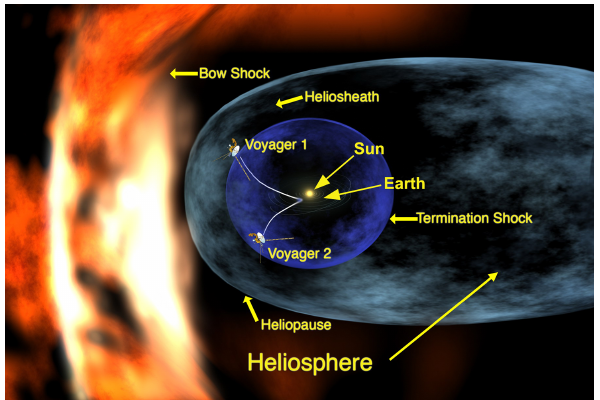
Figure 3. Schematic of the heliospheric boundaries (credit: NASA/Walt Feimer).